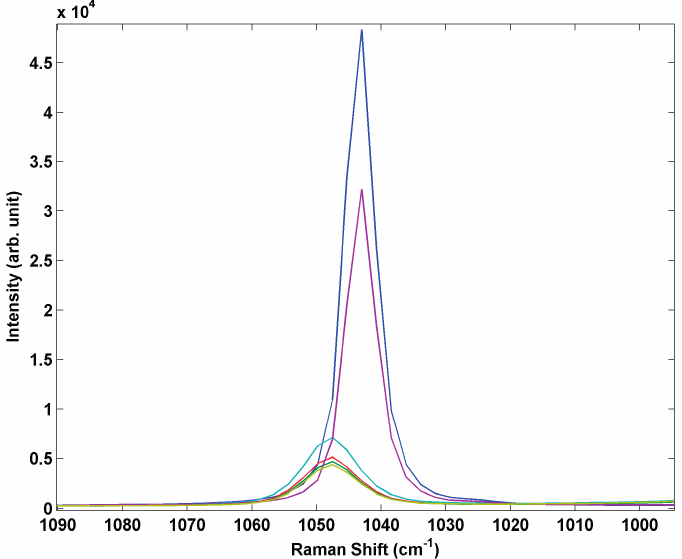
Figure 8. Comparison of Raman spectra of inkjet test materials containing both liquid and solid AN